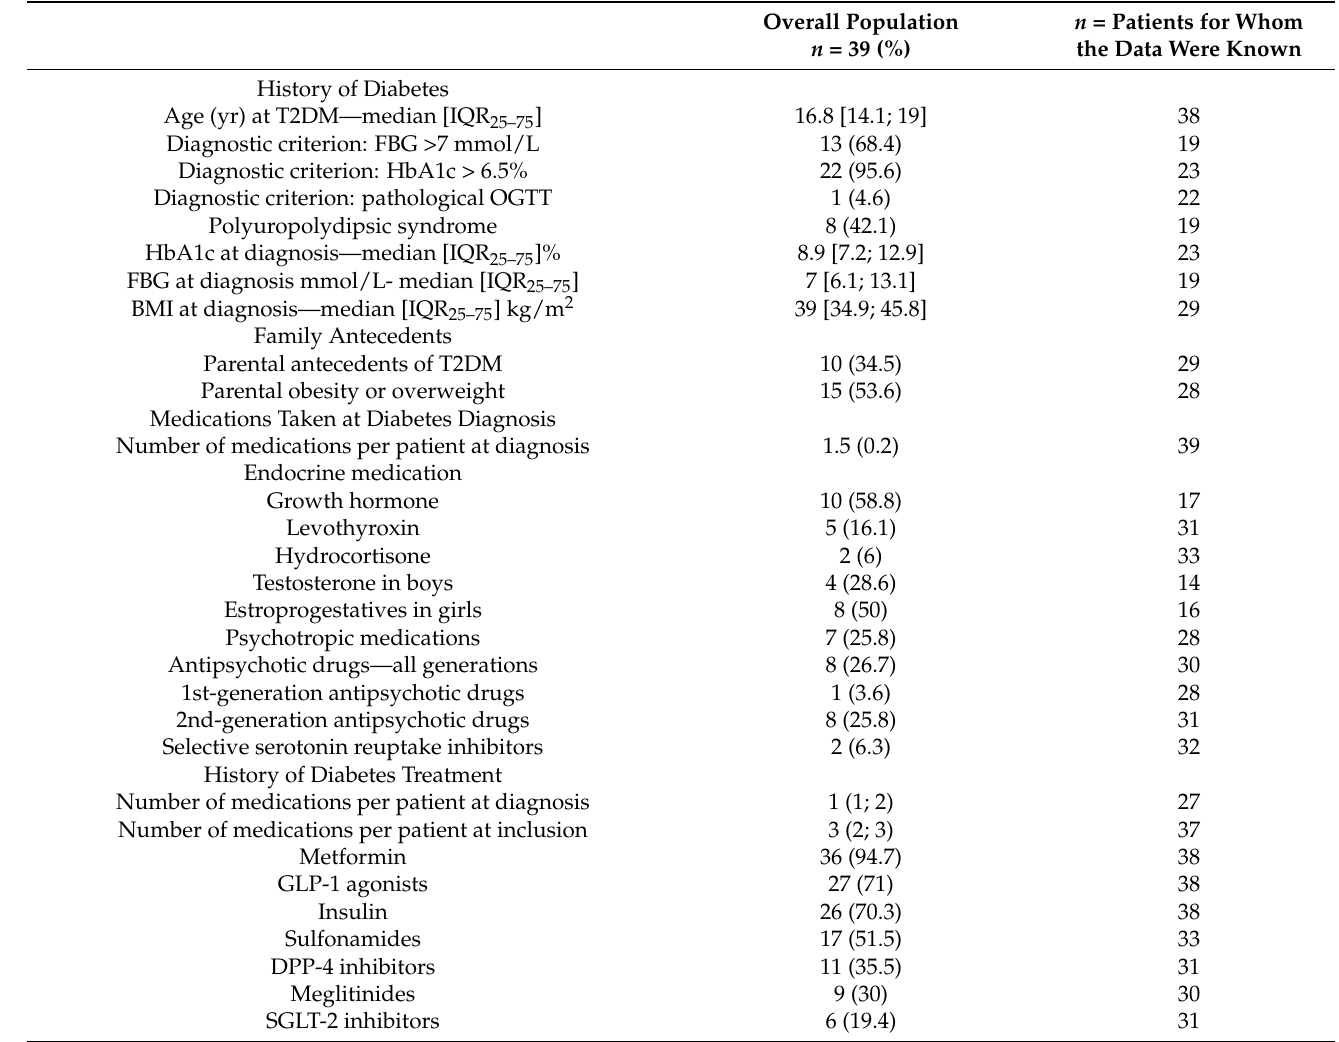
Table 2 describes the characteristics of T2DM in our population. Table 2. Description of diabetes in the population ( n =